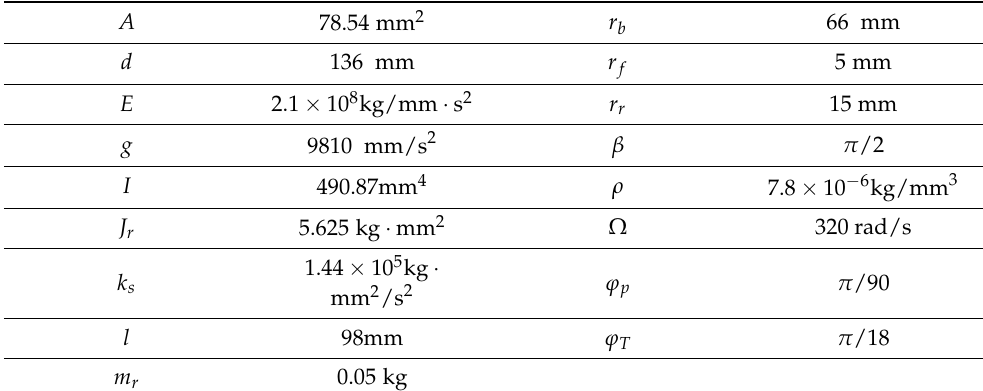
Table 1. Data for the cam system